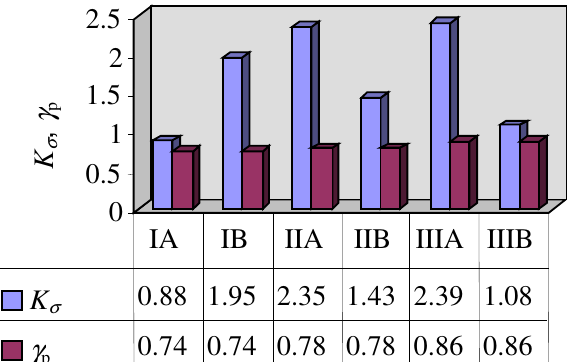
Fig 3. Stress concentration factor K σ and porosity γ p depending on model cell form and orientation the analogous reasoning, the behaviour of models IIA, IIB, and IIIA, IIIB can be